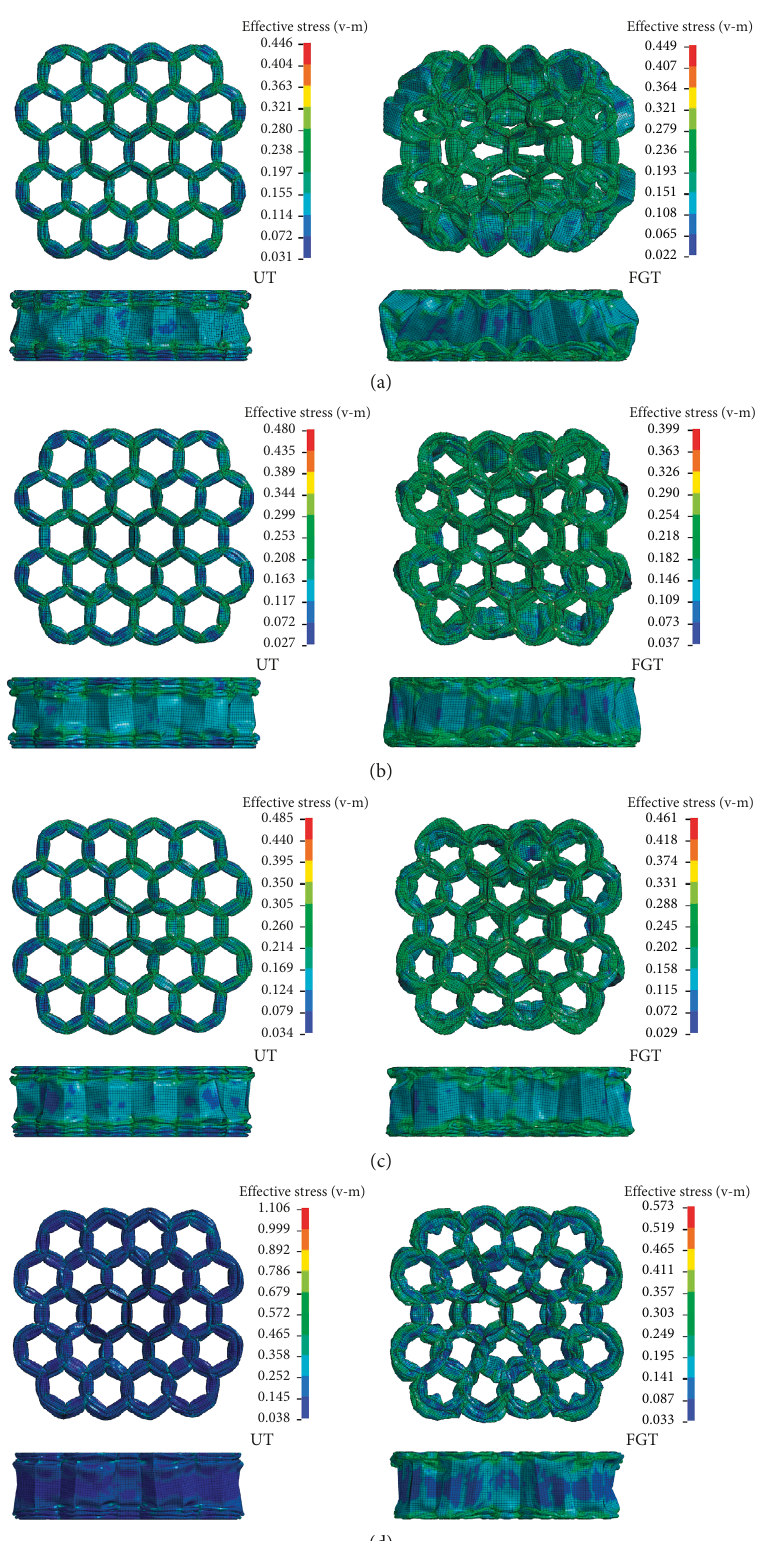
Figure 13: Comparison of deformation and effective stress distribution of UT and FGT honeycomb structures with 22 cells. (a) SEA � 18.5kJ/kg. (b) SEA � 20kJ/kg. (c) SEA � 22kJ/kg. (d) SEA �